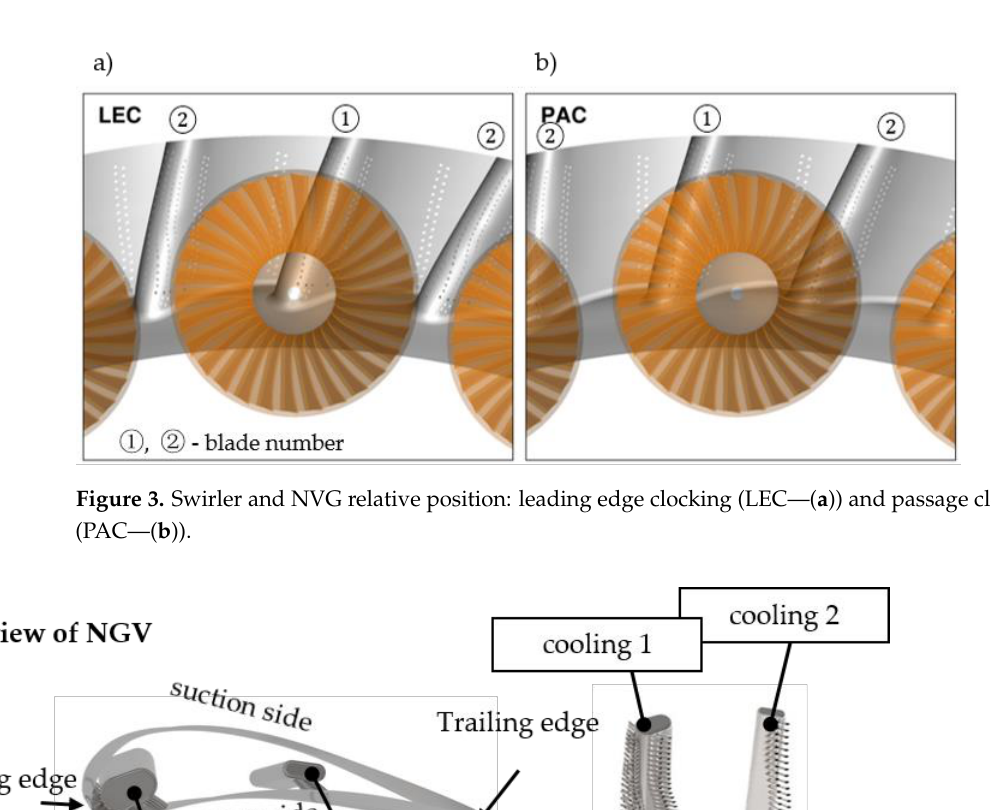
Figure 2. Computational domain for a combustor simulator ( a ) and a combustor simulator with NGV ( b ).